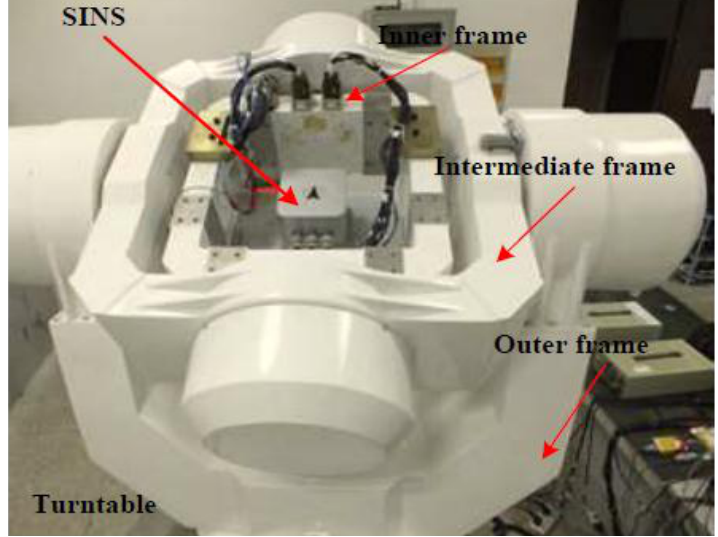
Figure 13. The turntable and the IMU.